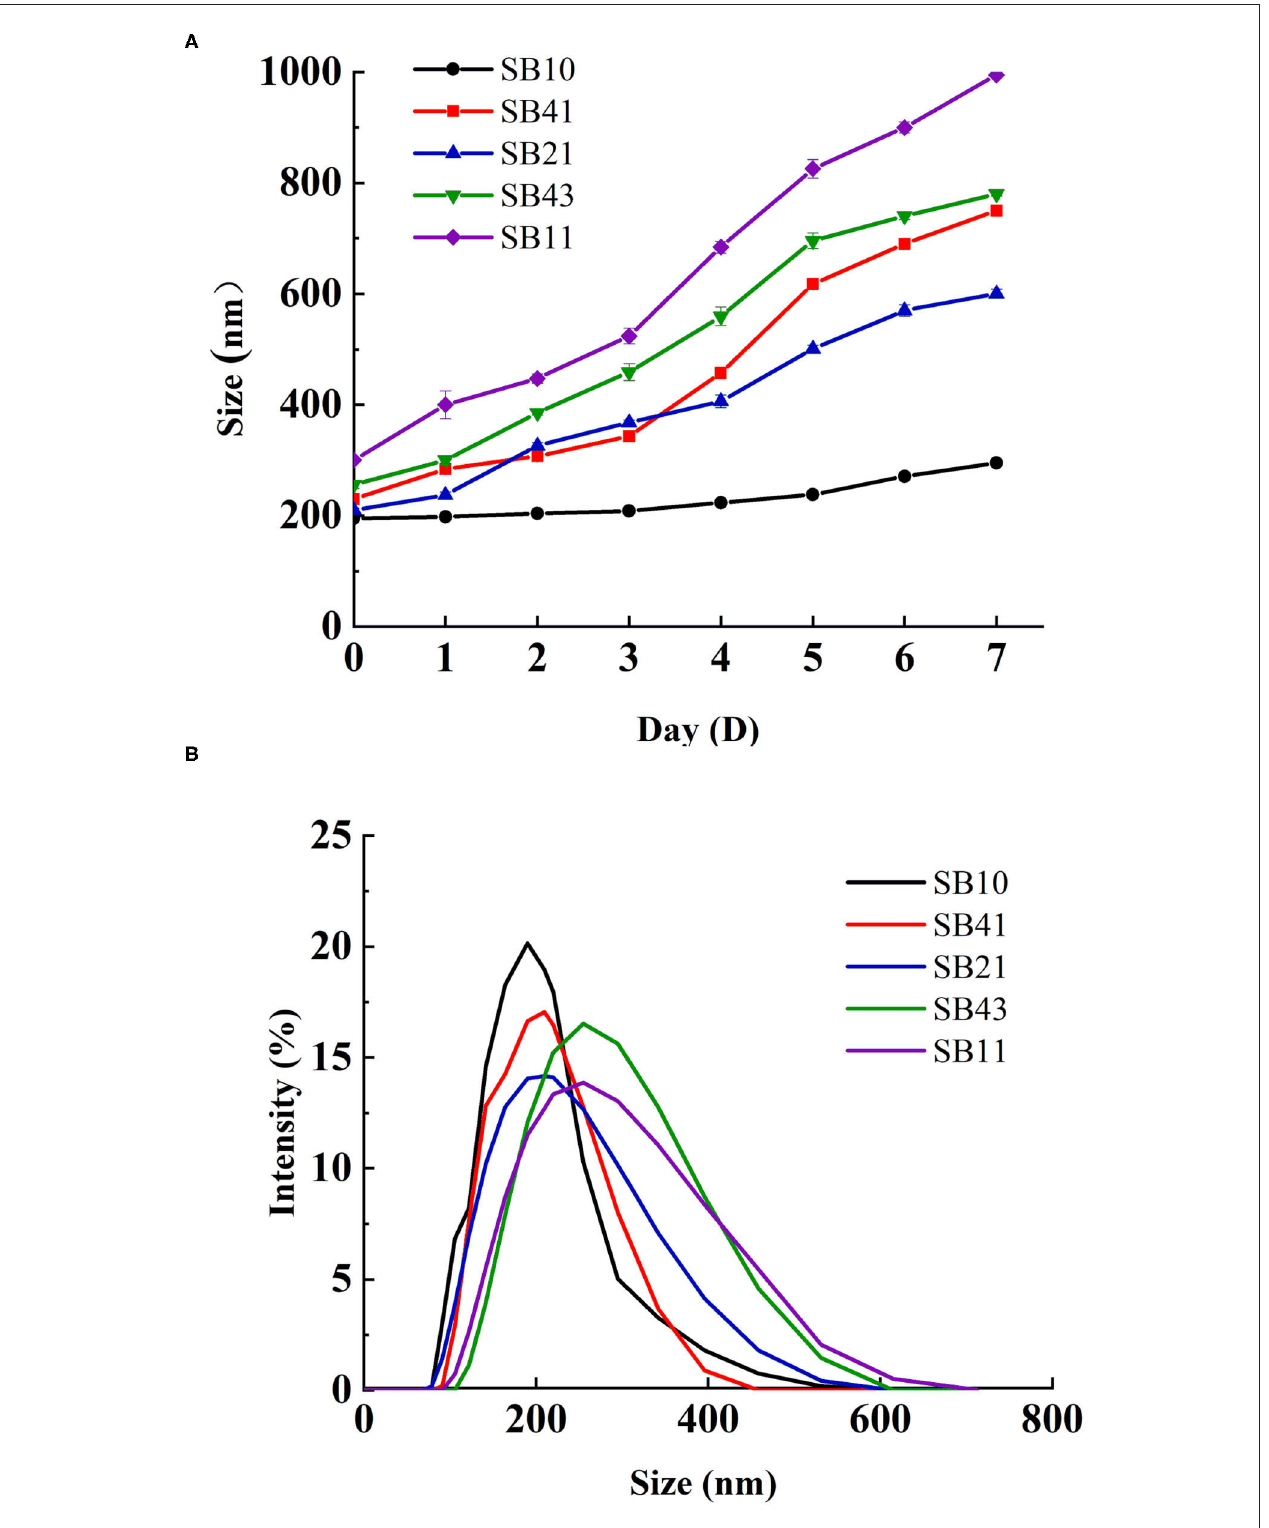
FIGURE 3 | Changes of the emulsions in the average droplet size during storage for 7 days at 25 ◦ C (A) . Droplet size distribution of the emulsions (B) .